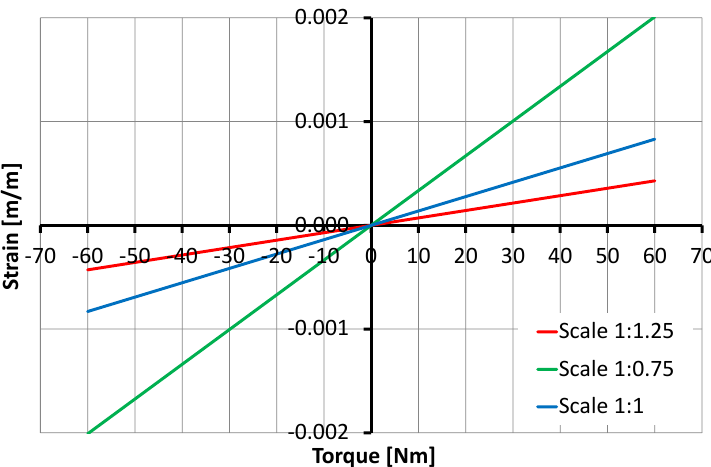
Figure 12. Relationship between torque and the strain with size: variations of 25% influence torque sensor